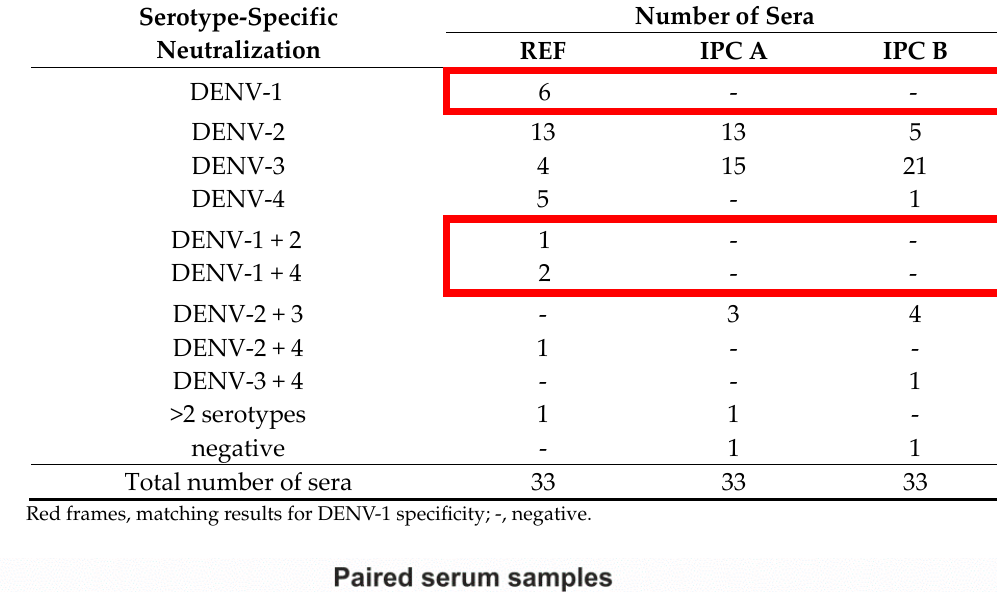
Table 5. Serotype-specific neutralization in 33 DENV-1-positive Cambodian sera from Table 4.